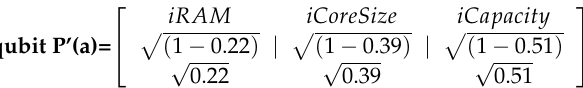
Table 4. Computation Node Parameters (mParameter = Available − Value